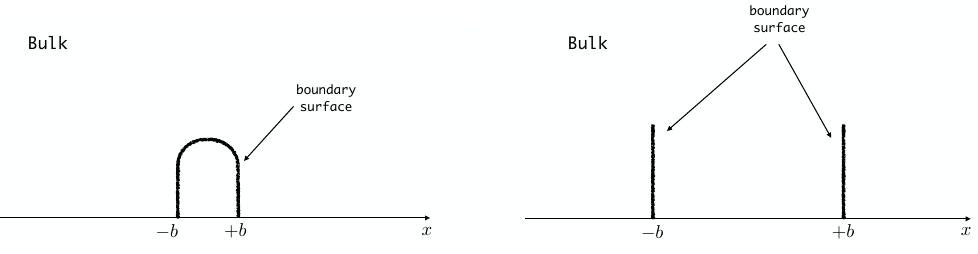
Figure 41 . Time slice t = 0 of the bulk in double splitting quench. The left (cid:12)gure shows case (I) thermal AdS phase and the right (cid:12)gure shows case (II) BTZ phase. This is the expected description of how the Hawking-Page transition should be realized in ( x; t; z )